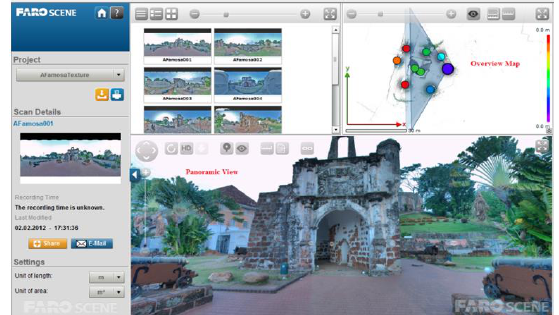
Figure 6. The A'Famosa fortress in SCENE WebShare View 4.